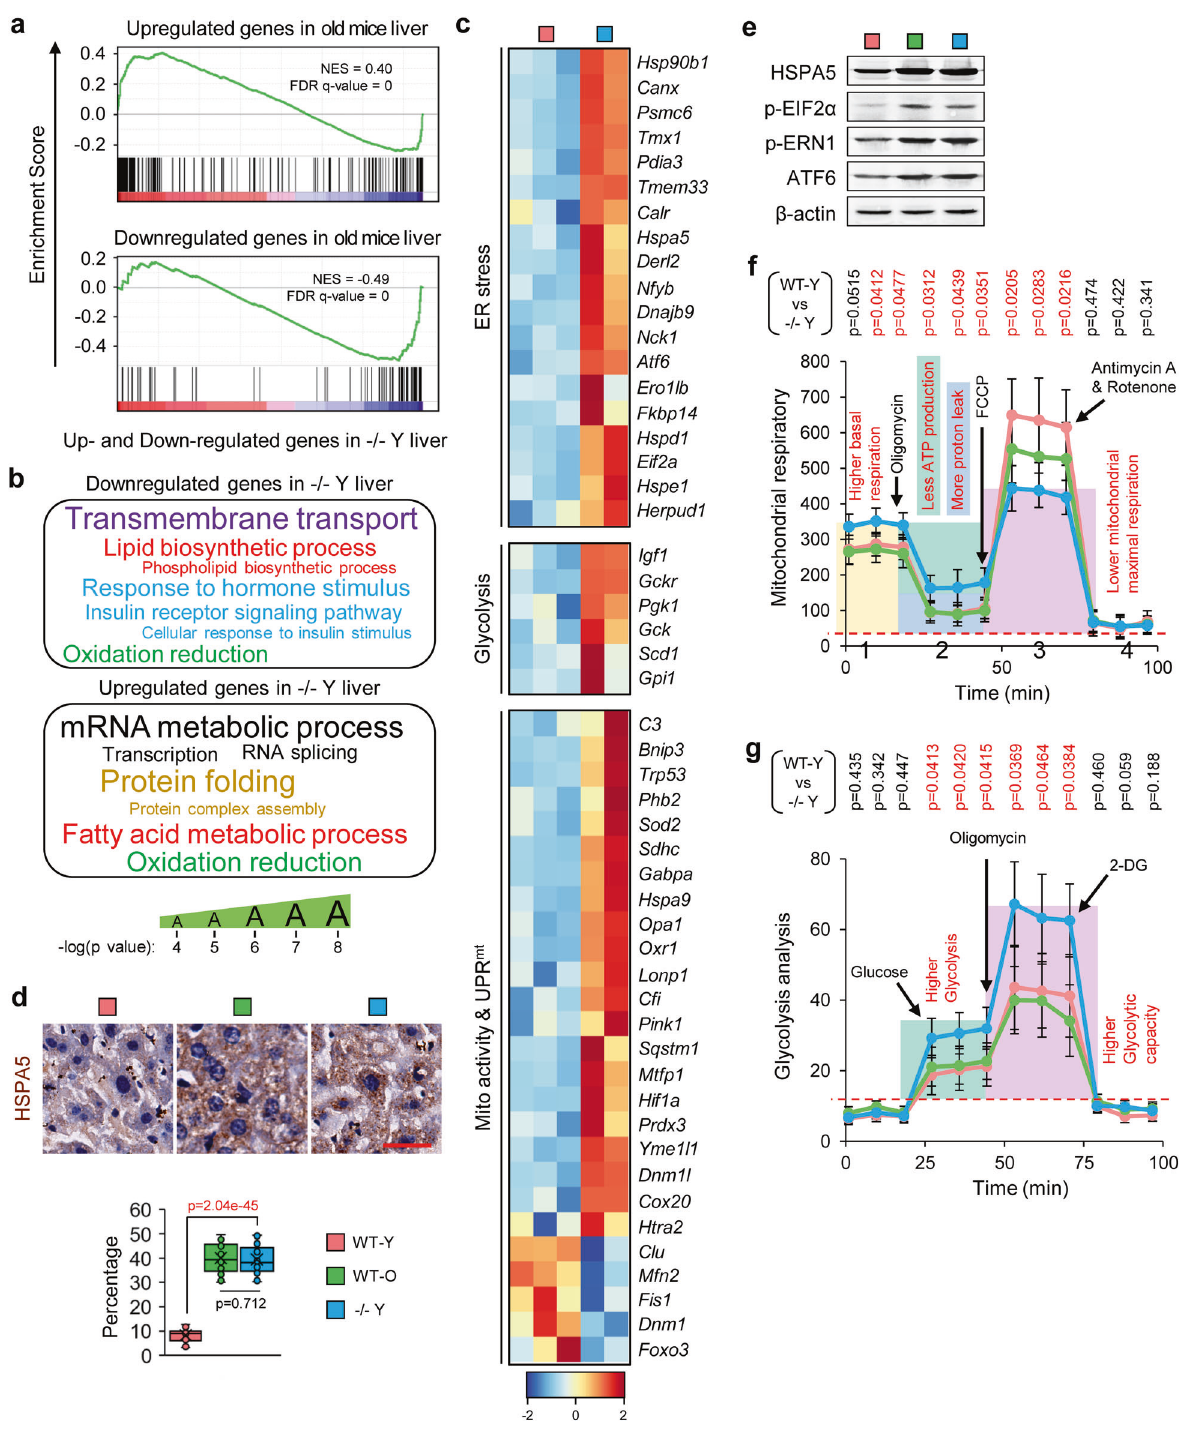
Fig. 5 Elovl2 de fi ciency led to endoplasmic reticulum stress and mitochondrial dysfunction. a Enriched gene sets of differentially expressed genes in − / − Y samples. The horizontal axis represents the differentially expressed genes in − / − Y compared to WT-O samples which were ranked as either up- or downregulated in − / − Y and marked in red and blue, respectively. The normalized enrichment score (NES) and false discovery rate (FDR) are marked. b The Gene Ontology terms enriched in up -or downregulated genes in − / − Y compared to WT-Y mice. The actual p values were shown in Supplementary Table 2. c Expression pattern of genes in aging-related pathways of different expression genes in − / − Y mice compared to WT-Y mice ( n = 3 for WT-Y and n = 2 for − / − Y). d HSPA5 staining in liver. Error bars, SEM. For each group 40 slices from fi ve mice were sed for statistical analysis. Levels of signi fi cance were calculated with two-tailed Student ’ s t test. e Western blotting for the markers of ER stress ( n = 3). f The Seahorse XF mitochondrion stress test ( n = 4). Error bars, SEM. Levels of signi fi cance were calculated with one-tailed Student ’ s t test. g The Seahorse XF glycolysis test ( n = 4). Error bars, SEM. Levels of signi fi cance were calculated with one-tailed Student ’ s t test